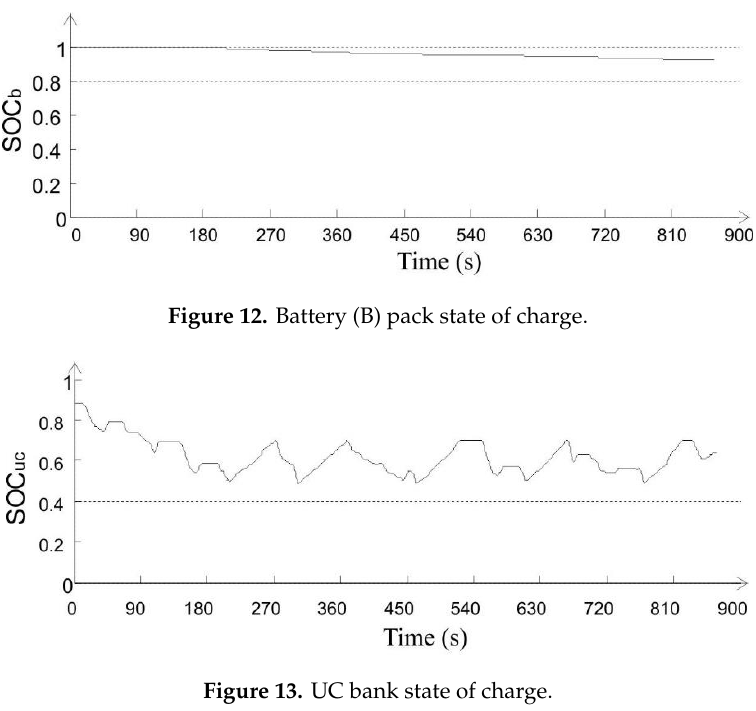
Figure 13. UC bank state of charge.